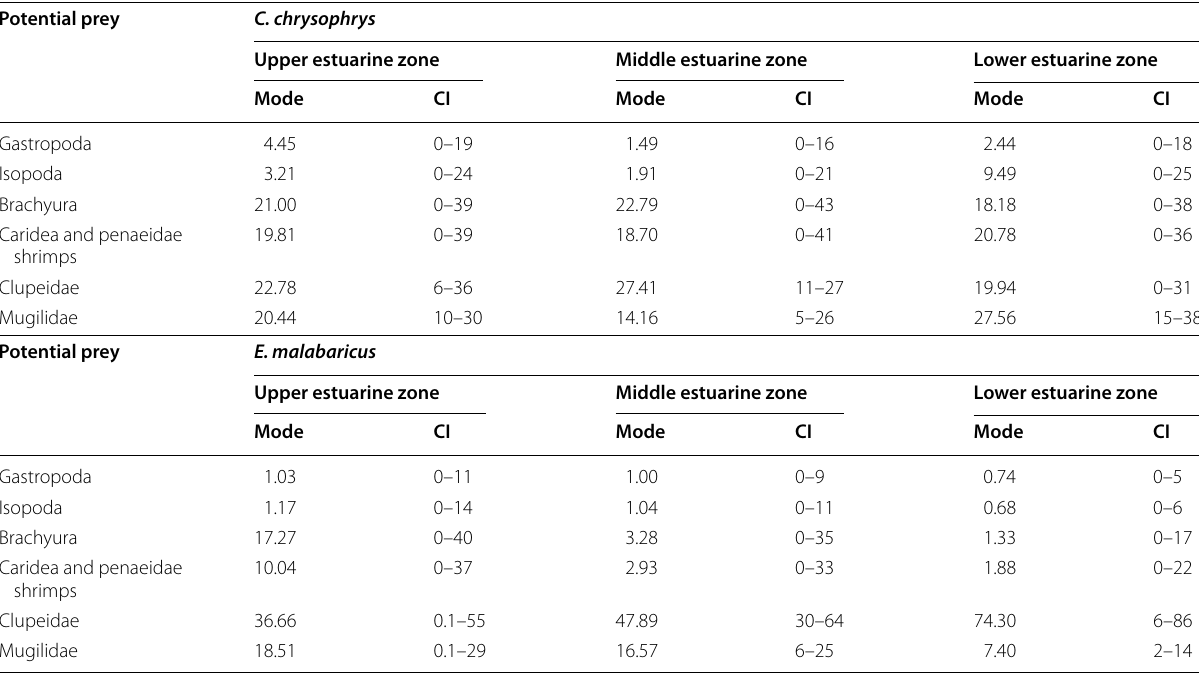
Relative contributions of dietary sources to predatory fish reported as mode (central tendency) with 95% CI Table 6 Isotopic niche data of Carangoides chrysophrys and Epinephelus malabaricus in the Pangani estuarine zones Isotopic niche